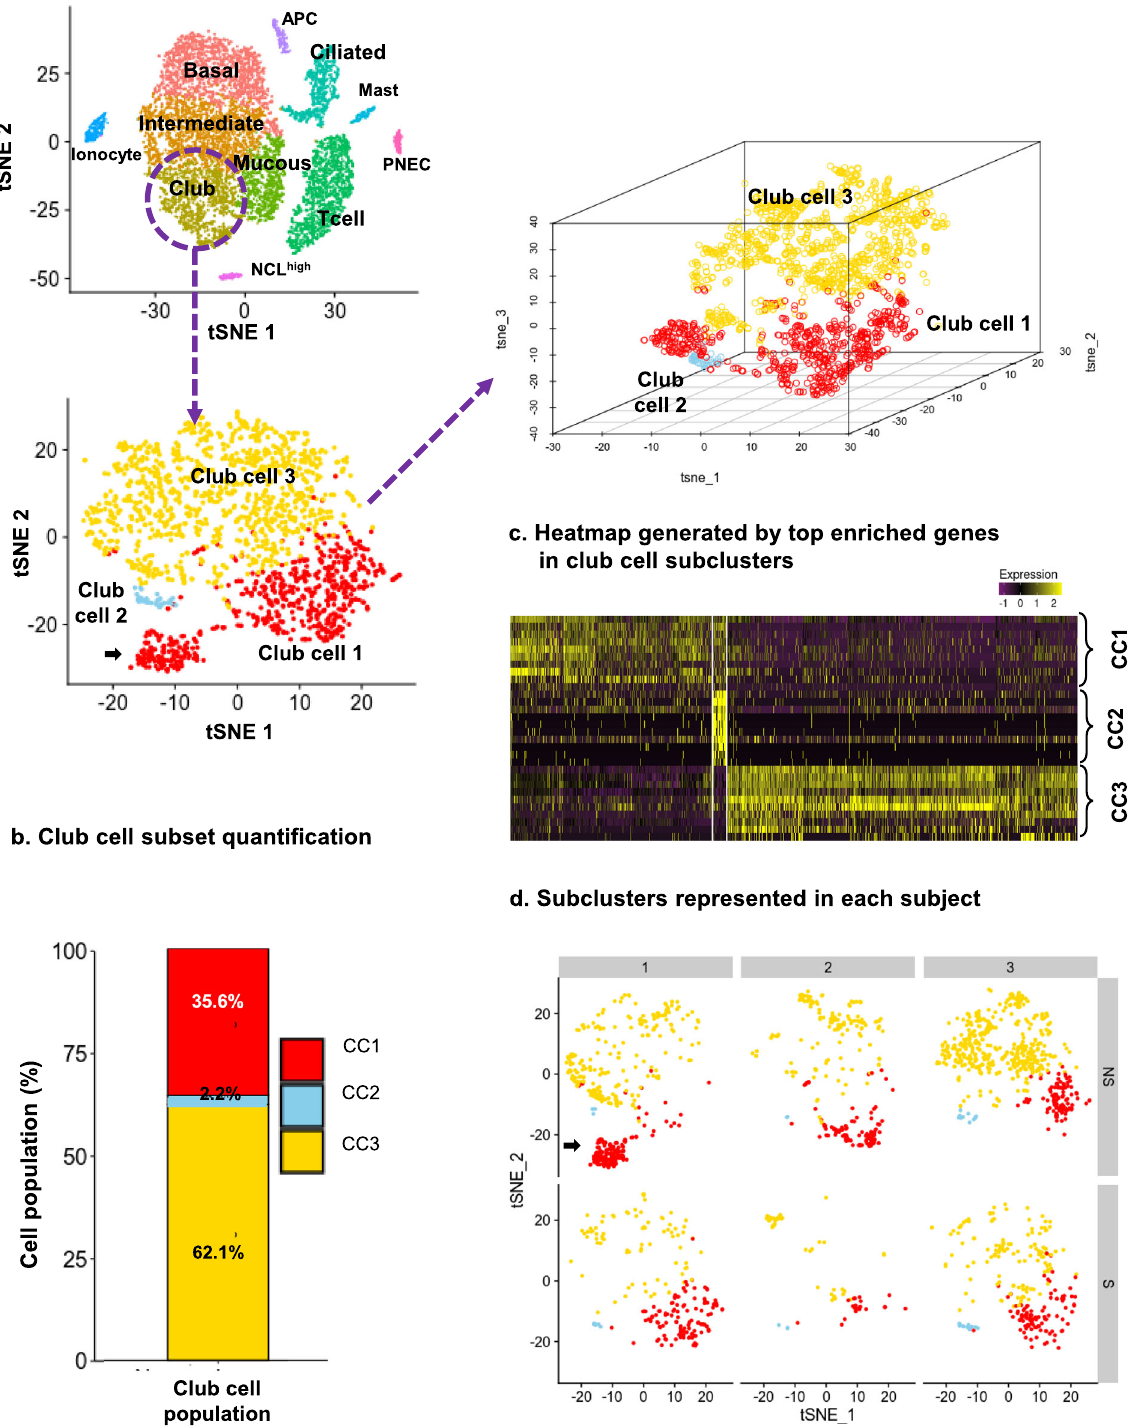
GAGE functional analysis To de fi ne potential functional output of the three club cell subsets, GAGE was employed to examine biological processes enriched in the gene expression pro fi les of each subset 35 . Pathway analysis identi fi ed that club cell subcluster 1 was enriched in metabolic processes and ribosome biosynthesis, with minimal